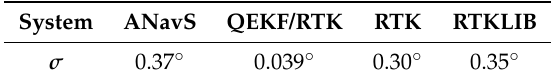
Table 1. Standard deviations during the static